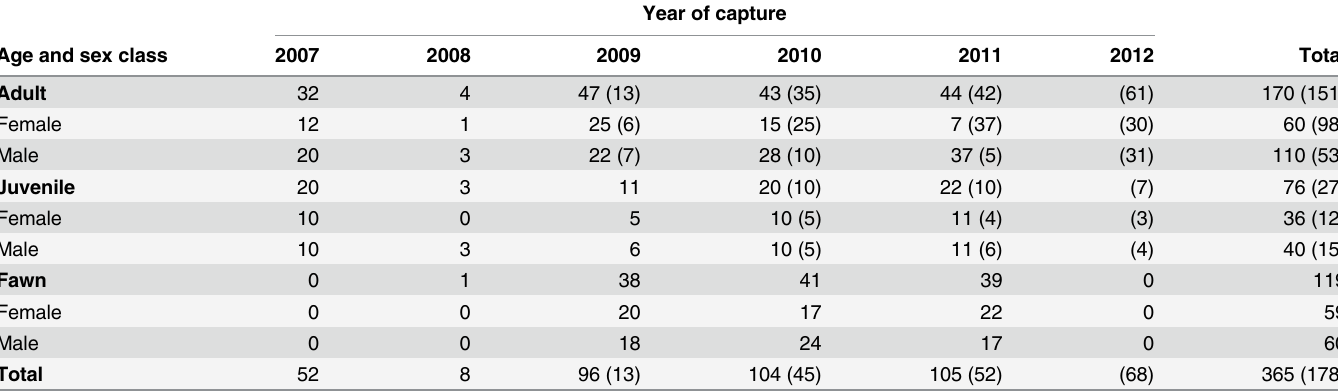
Table 1. Annual numbers of newly captured (and recaptured) mule deer in Antelope Creek by age and sex